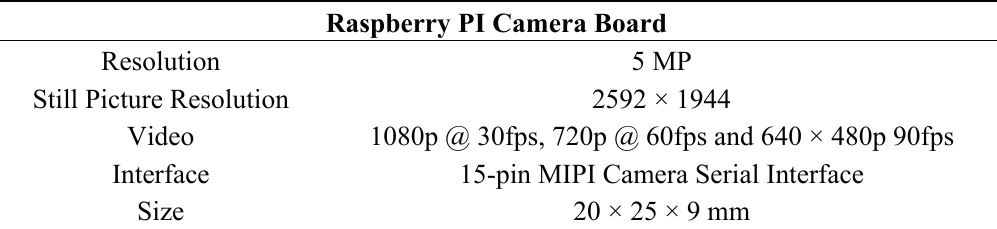
Table 11. Specifications of the camera.